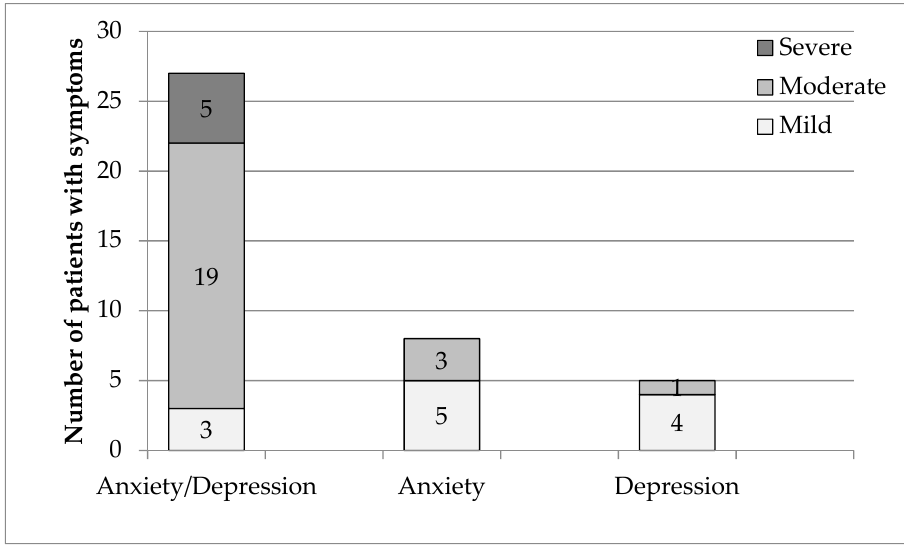
Figure 1. Type of disorders and their degree before therapy. Table 3. Assessment of the degree of disorders according to the HADS scale in patients before the introduction of physiotherapeutic rehabilitation.